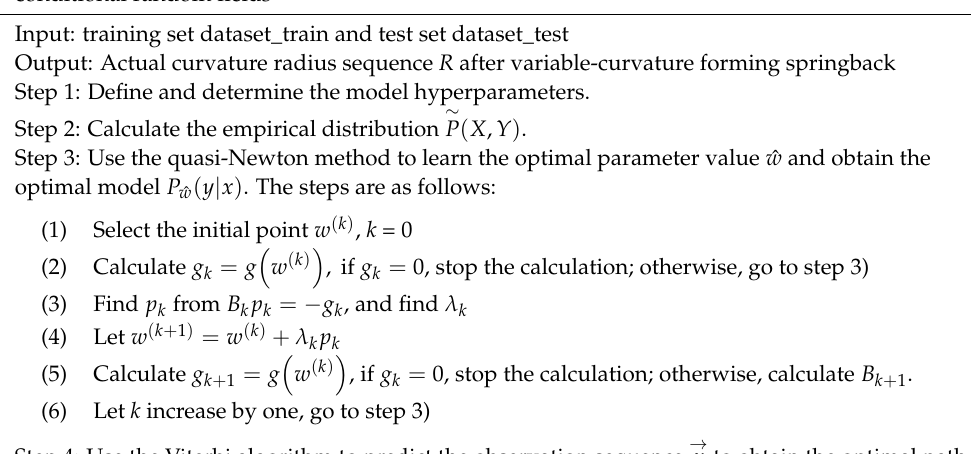
Algorithm 2: Curvature prediction after springback for variable-curvature roll bending based on conditional random fields